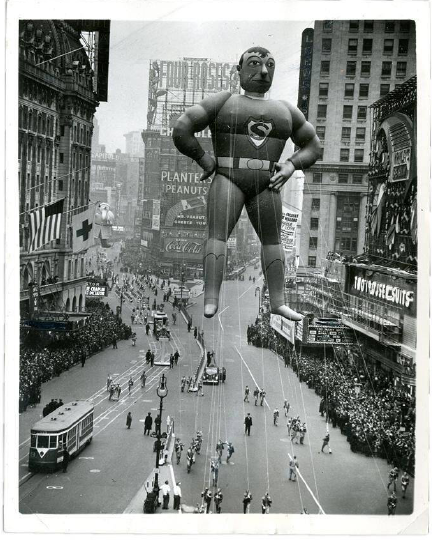
Figure 2. Tony Sarg (designer), Superman Balloon in the Macy’s Thanksgiving Parade , 1940, 2286 × 1341 cm. Photo: Wiki Fandom, Creative Commons.